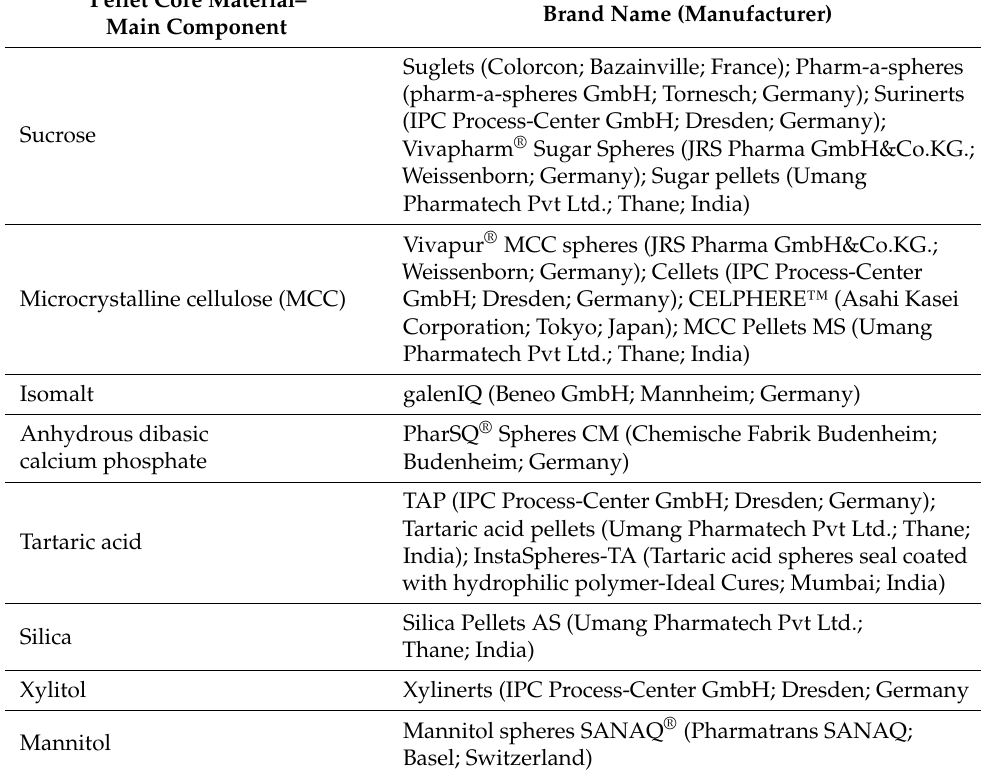
Table 1. Commercially available starter spheres (based on [19,20]